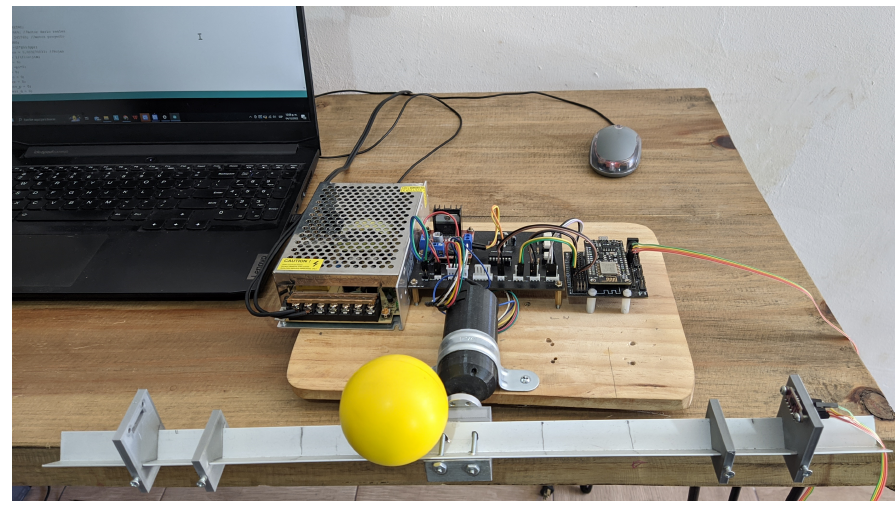
Figure 4. Full system, including microcontroller and power electronics.